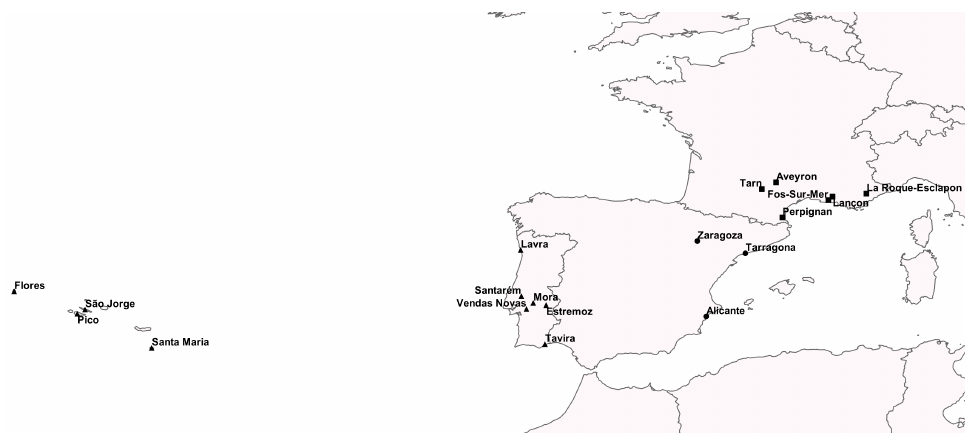
Figure 2. Map with the geographical locations of the populations used in this study. Marked with ( ● ) are O. c. algirus populations from Portugal, with ( ■ ) are O. c. cuniculus from Spain and with ( ▴ ) O. c. cuniculus from France.